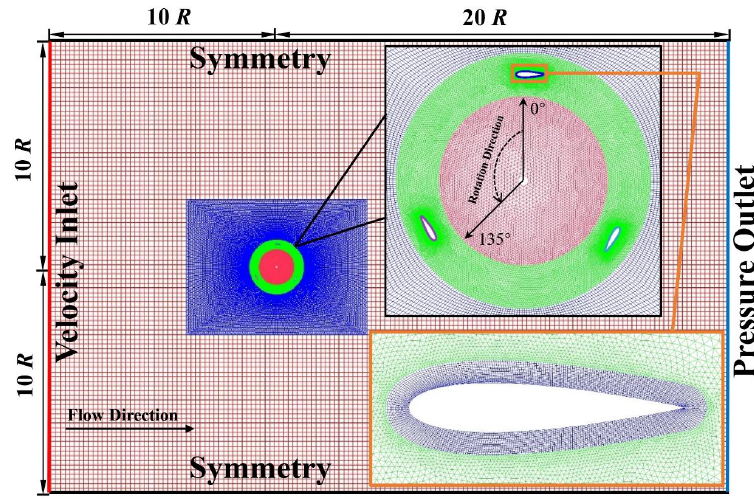
Figure 1. 2D computational domain, boundaries and meshes.